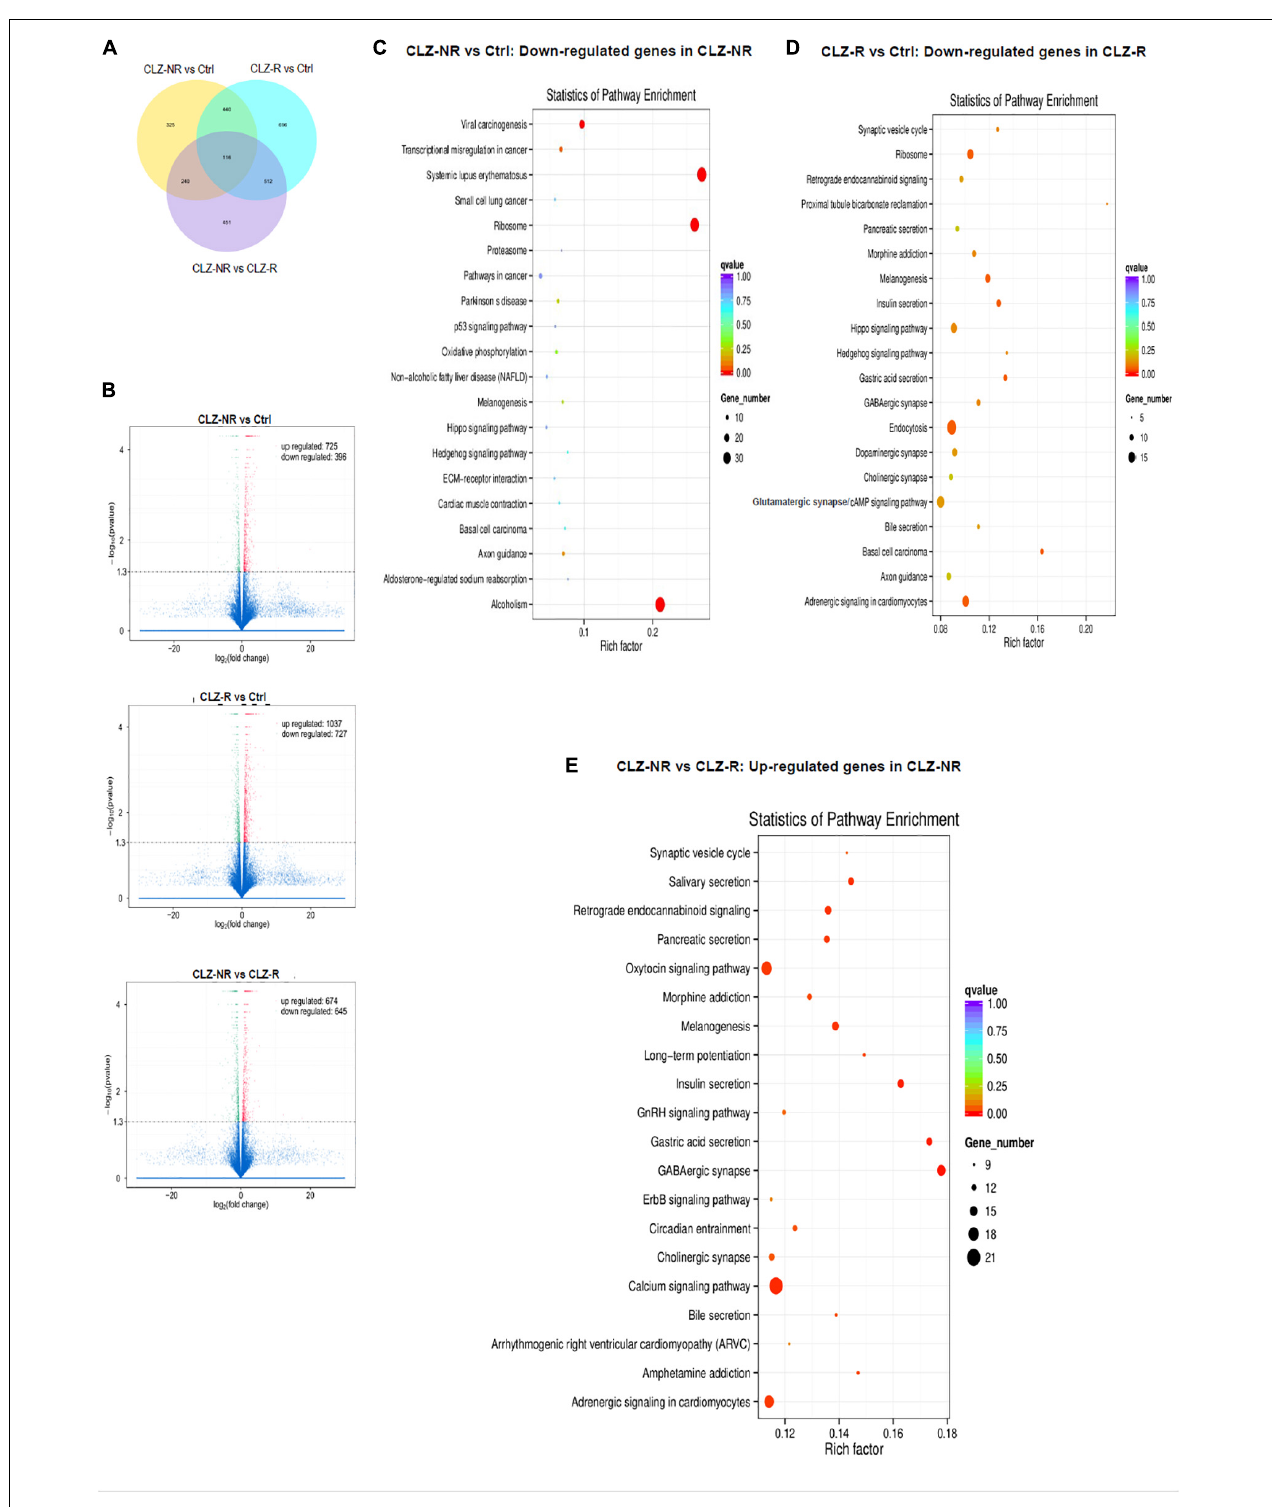
FIGURE 5 | RNAseq profiles in clozapine responsive and resistant subjects. The results of transcriptomic profiling. (A) The number of gene expression changes. (B) Volcano plots comparing gene expression profile differences between clozapine responsive (CLZ-R), clozapine resistant (CLZ-R) and healthy controls (Ctrl). Pathway enrichment analysis comparing clozapine resistant patients with controls (C) , clozapine responsive patients with controls (D) , and clozapine resistant and responsive patients (E) .